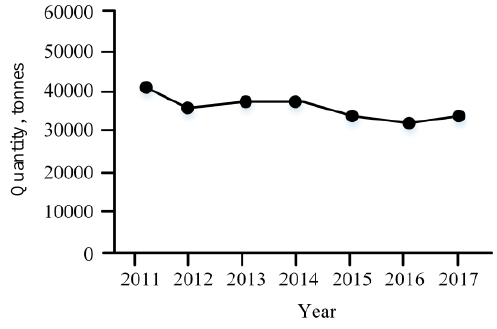
Fig. 1. Evolution of urban waste production in Terceira Island [24].